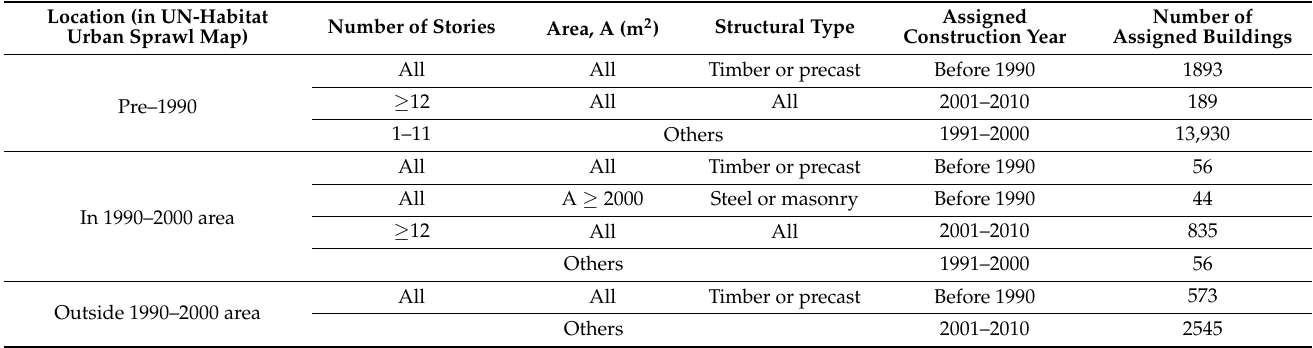
Figure 5. Comparisons of estimated structural types and ground photos: ( a ) Estimated inventory data; ( b ) ground photos in Google Street View [31]. Table 6. Criteria for defining construction